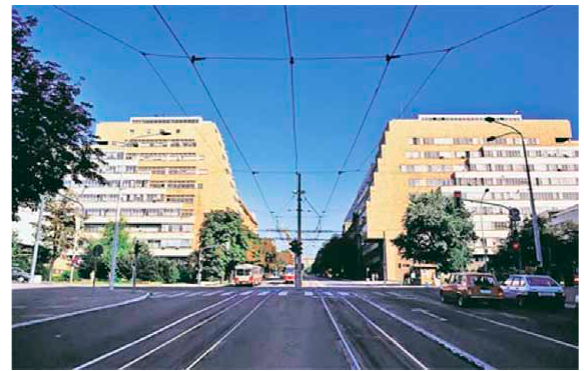
fig. 3. The army Headquarters prior to 1999 bombardments in a recognizable total of two buildings and the main portal motif from the direction of the Main railway Station. Buildings a and B are on the left and right side of the picture, respectively. Source : Kovačević